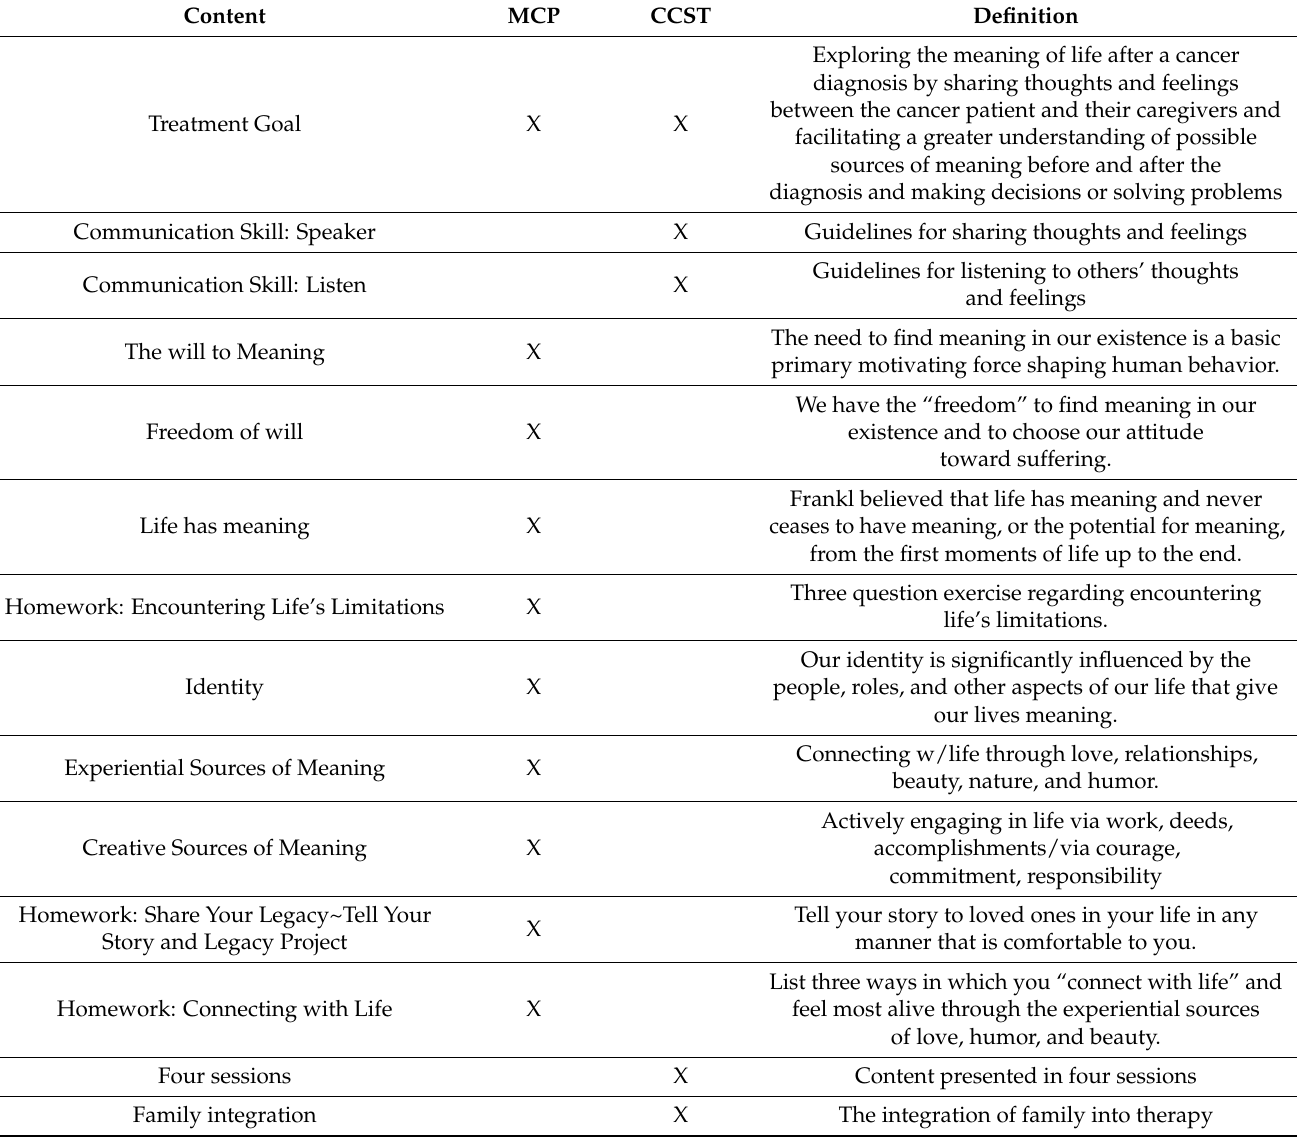
Table 1. Caregivers–Patients Support to Latinx coping advanced-cancer” (CASA) content presented in the interview. The X indicate the inclusion of intervention related